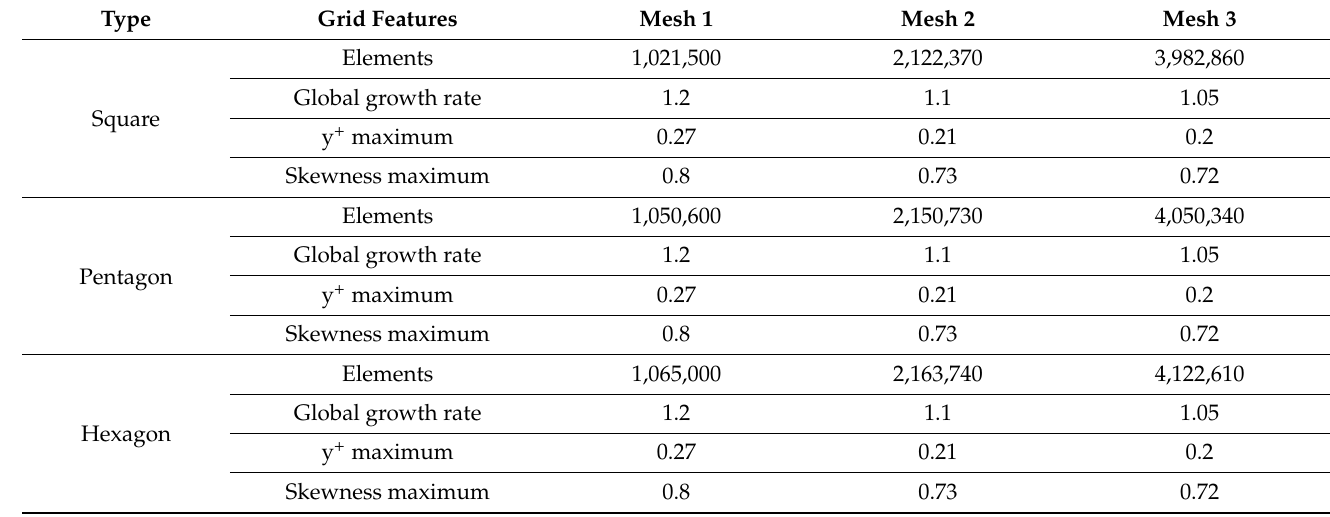
Table 2. Mesh independence study